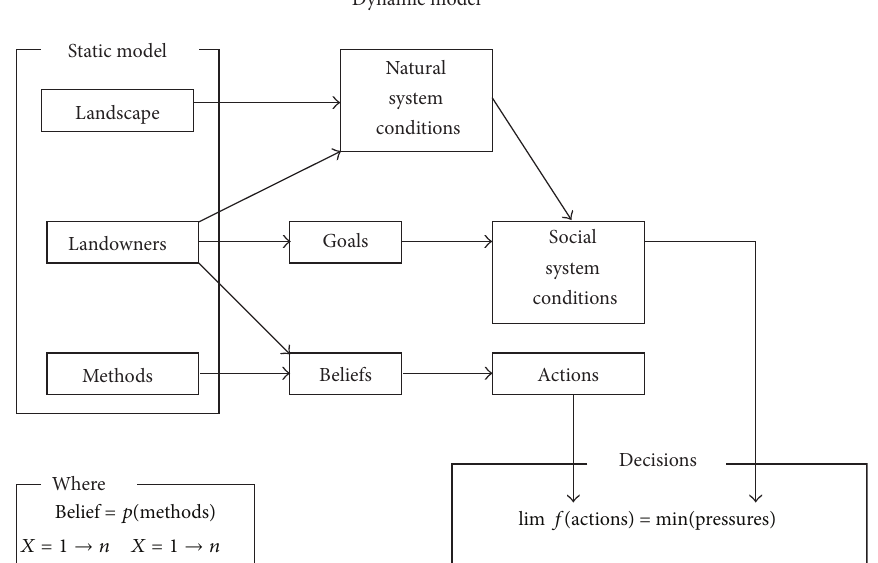
Figure 2: The FLAME dynamic constructs. The static model parameters of landscape, landowner, and methods ultimately drove the dynamic system. Landowners evaluated their natural conditions and priority goal scores as well as communicated. Beliefs interacted with methods (actions available) to represent their perception on how well a given action would meet their goal. The decision engine chose the perceived optimal action that would improve landowners’ goal